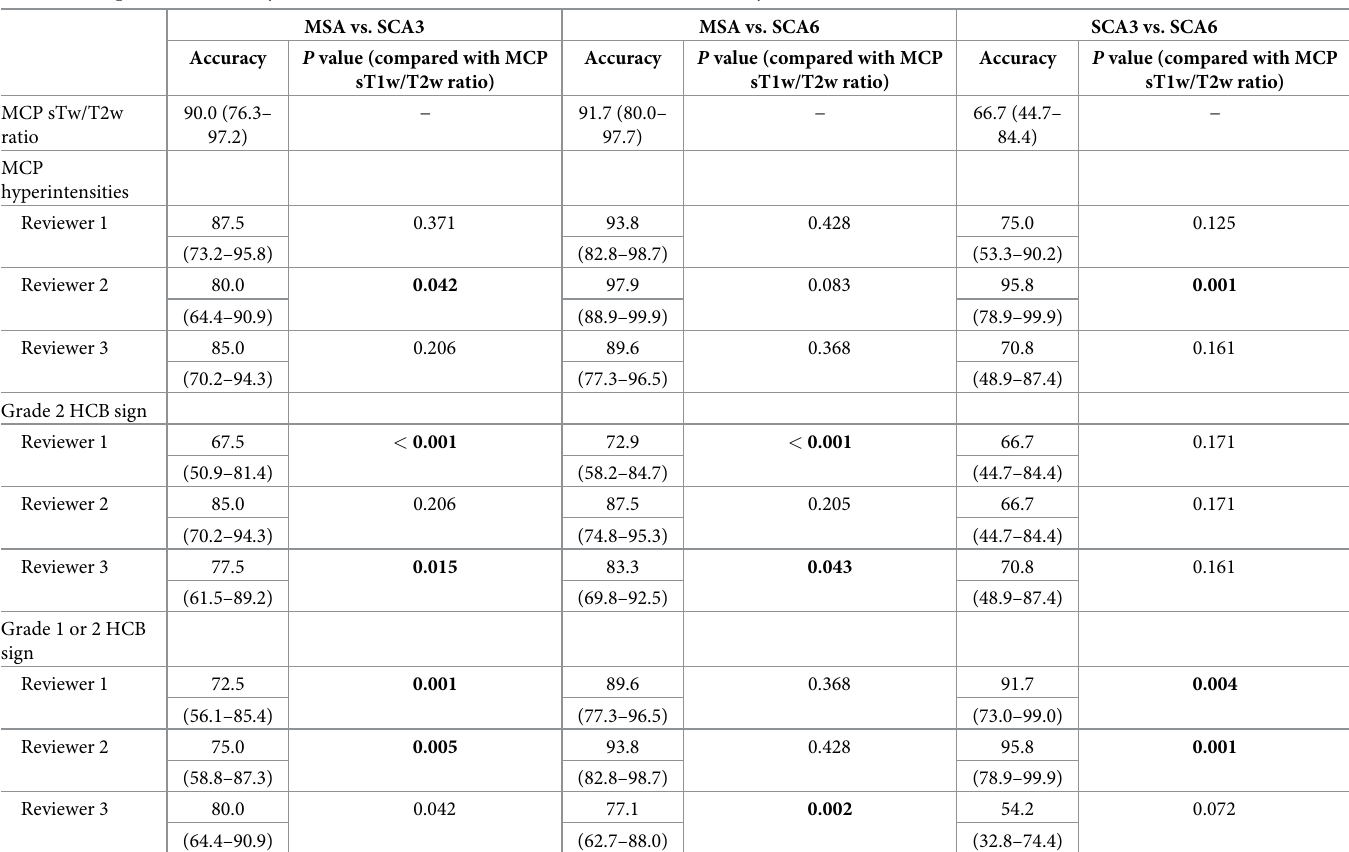
Table 3. Comparison of accuracy between the MCP sT1w/T2w ratio and visual evaluation by three